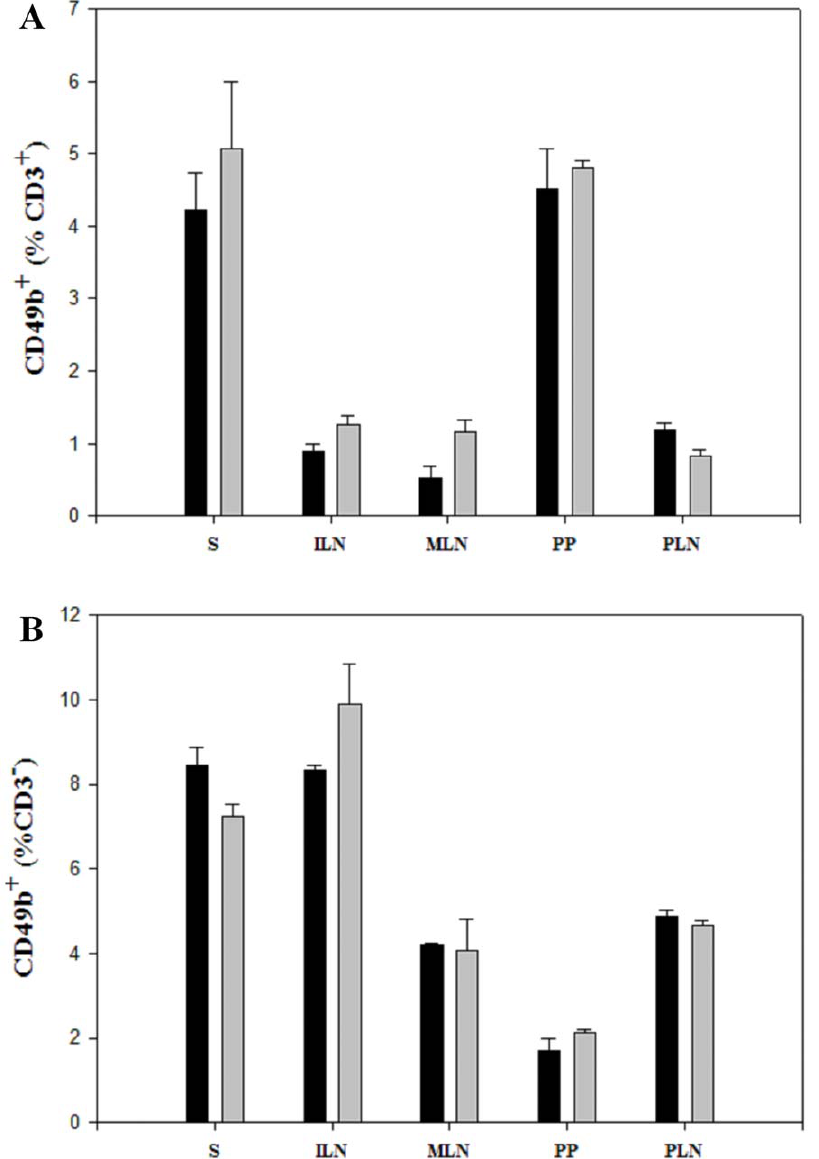
Figure 7. No diet-induced difference was found in the proportion of CD3 + CD49b + (NKT cells) or CD3 2 CD49b + (NK cells). ( A ) Bars represent the proportion of CD49b + cells, gated on 100% CD3 + cells. No diet induced differences was found. ( B ) Bars showing the percentages of CD3 2 CD49b + cells, with no significant differences between the two diets. Barplots are mean values 6 SEM of two independent experiments with 6 mice in each group. Spleen (S); inguinal lymph nodes (ILN); mesenteric lymph nodes (MLN); Peyer’s patches (PP) and pancreatic lymph nodes (PLN). Black bars: STD diet. Grey bars: GF diet.